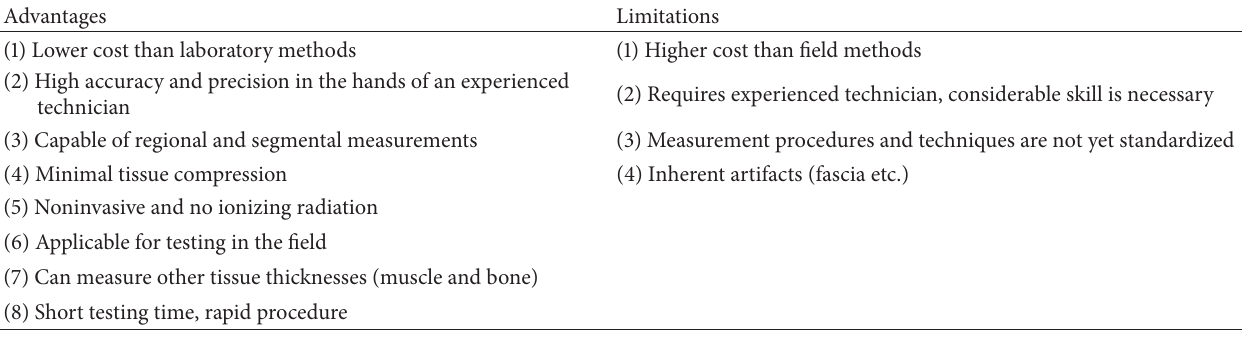
Table 1: Advantages and limitations of using ultrasound for assessing body fat.